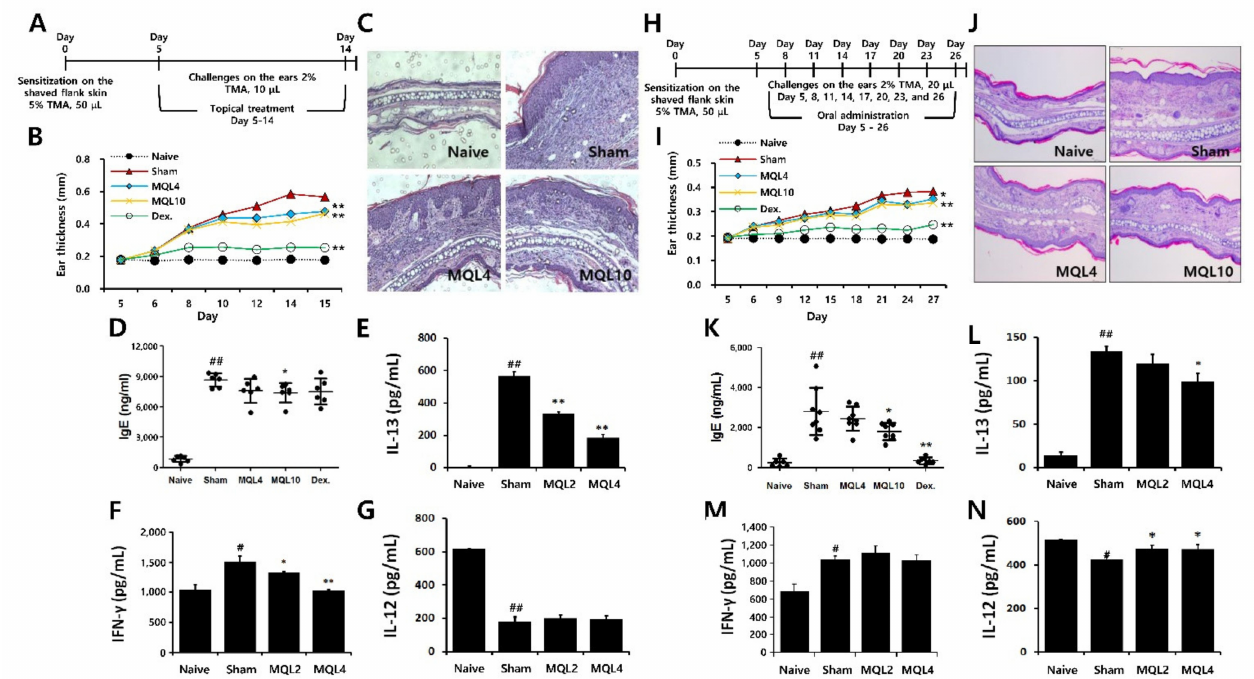
Figure 6. Effects of topical and oral administration on TMA-induced AD symptoms. ( A ) Experimental schedule of the TMA-induced AD-like mouse model with topical treatment of MQL. Cells from DLNs (1 × 10 6 cells/mL) were seeded and cultured in the presence of Con A (2 µ g/mL) for 48 h. An experimental AD-like lesion was induced on the shaved flank skin of BALB/c mice by sensitization with 5% TMA (50 µ L) on day 0, followed by treatment with 2% TMA (10 µ L) on days 5 to 14. MQL (4 and 10 mg/mL, 10 µ L) and Dex (1 mg/mL, 10 µ L) were administered topically. ( B ) Ear swelling was measured 24 h after TMA treatment. ( C ) Infiltrating inflammatory cells in the ear tissues were stained using hematoxylin and eosin. The levels of ( D ) IgE in serum and ( E ) IL-13, ( F ) IFN- γ , and ( G ) IL-12 cytokines in culture supernatant of DLNs were measured using ELISA. ( H ) Experimental schedule of the TMA-induced AD-like mouse model with oral administration of MQL. An experimental AD-like lesion was induced on the shaved flank skin of BALB/c mice by sensitization with 5% TMA (50 µ L) on day 0 then treated with 2% TMA (20 µ L) on days 5, 8, 11, 14, 17, 20, 23, and 26. MQL (4 and 10 mg/kg) and Dex (1 mg/kg) were administrated by orally from day 5 to day 26. ( I ) Ear swelling was measured 24 h after TMA treatment. ( J ) Infiltrating inflammatory cells in the ear tissues were stained using hematoxylin and eosin. The levels of ( K ) IgE in serum and ( L ) IL-13, ( M ) IFN- γ , and ( N ) IL-12 cytokines in culture supernatant of DLNs were measured using ELISA. Results are shown as mean ± SD. # p < 0.05, ## p < 0.01, between the naïve and sham groups, * p < 0.05, ** p < 0.01, between the MQL-treated and sham